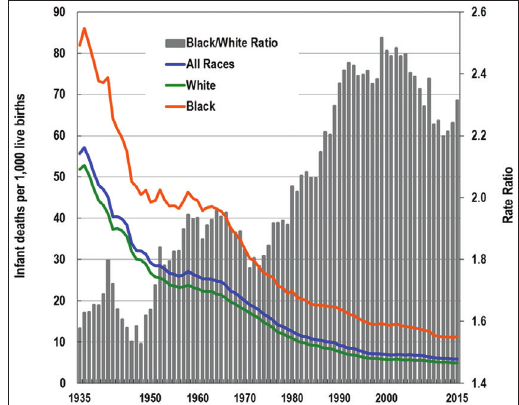
Figure 9. Infant Mortality Rate by Race, United States, 1935-2015 Source: Singh GK, van Dyck PC. Infant Mortality in the United States. A 75th Anniversary title V Publication. HRSA. 2010 (updated data) and